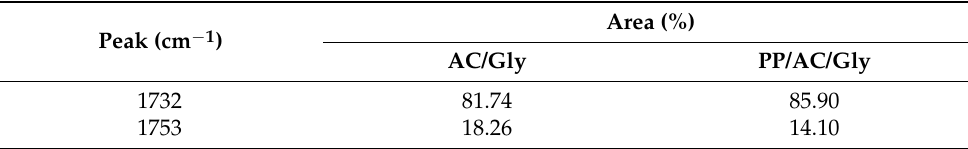
Table 3. Deconvoluted % of FT-IR data (carbonyl functional